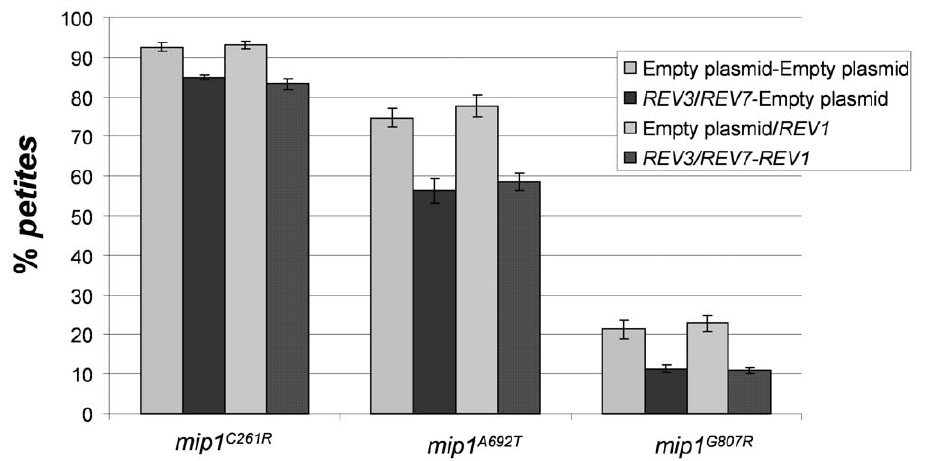
Figure 4. Petite frequency of mip1 mutant strains overexpressing Pol zeta, Rev1, or both. Petite frequency was measured as in Figure 2.